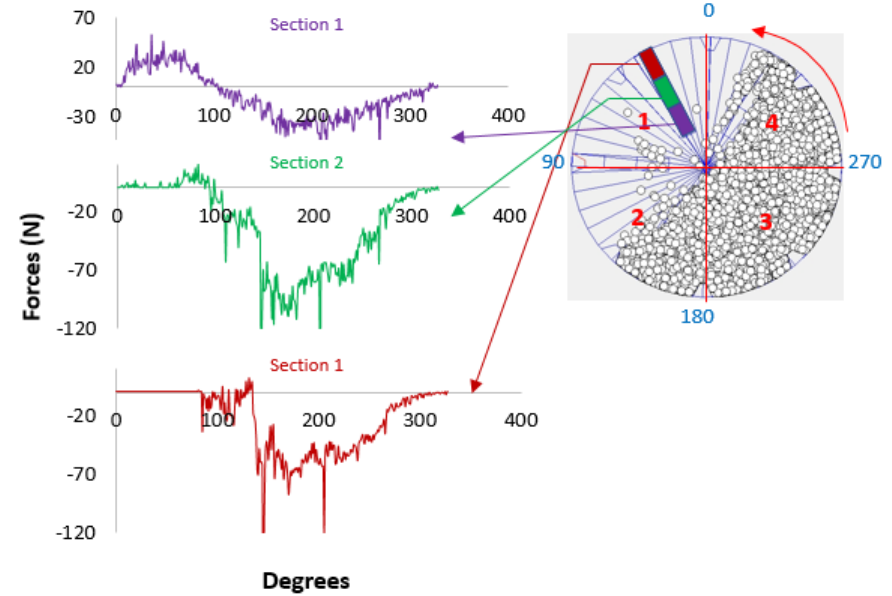
Figure 10. Tangential forces acting on the end liner when mill filling is increased to 40%.